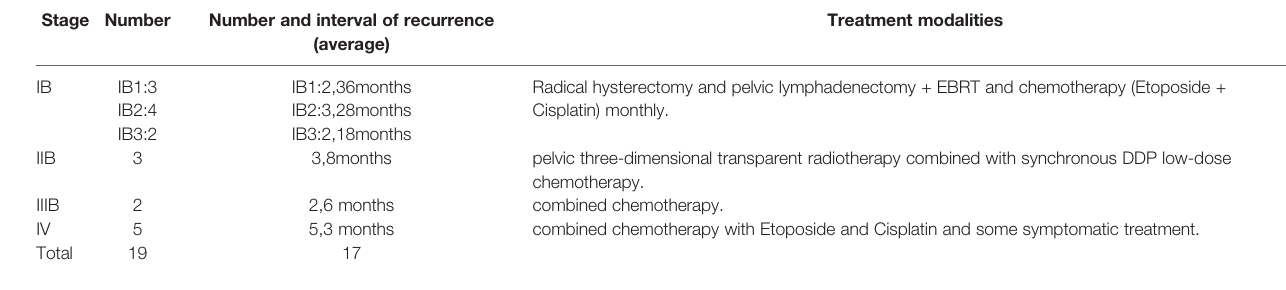
TABLE 2 | Treatment and prognosis of different stages. Stage Number